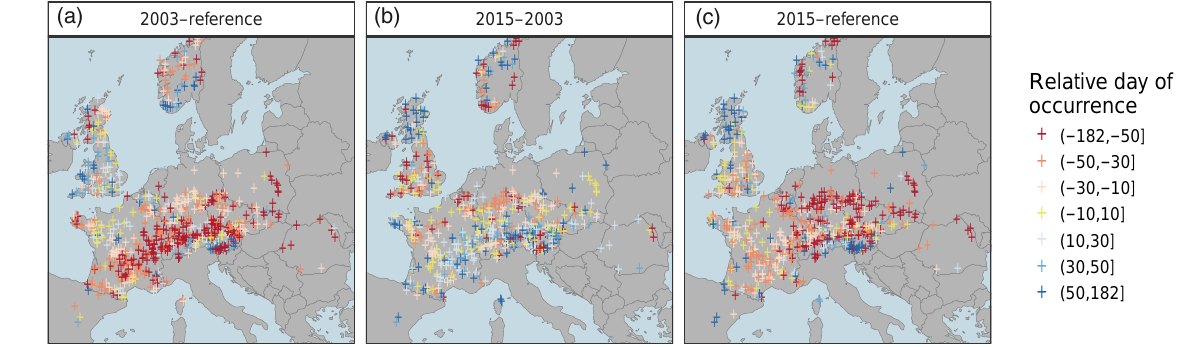
Figure 9. Relative day of occurrence (cid:49) τ of the onset of the events (a) of 2003 with respect to the reference period, (b) of 2015 with respect to 2003, and (c) of 2015 with respect to the reference period. Earlier occurrences (red) relate to relatively drier preconditions in winter or spring. Later occurrences (blue) relate to relatively wetter